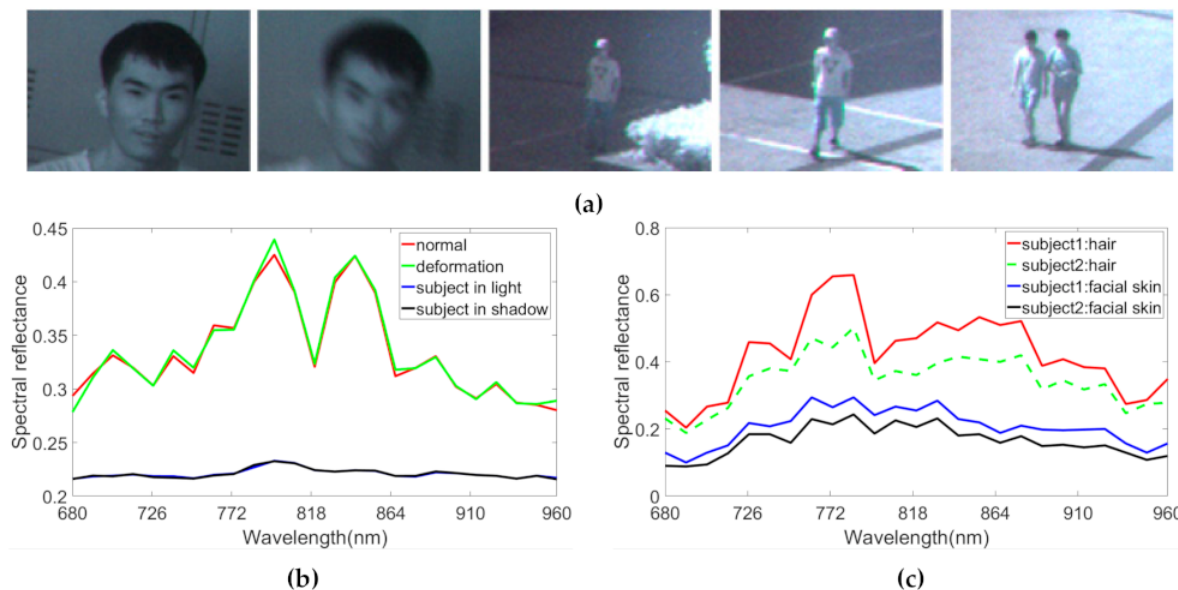
Figure 3. Sample images and their spectral reflectance. ( a ) Images are taken in various conditions (normal, deformation, object in shadow, object in light, and background clutter). ( b ) Spectral profiles of object in different states (normal, deformation and object in shadow, object in light). ( c ) Spectral signatures of facial skin and hair of the different subjects in the background clutter image of ( a